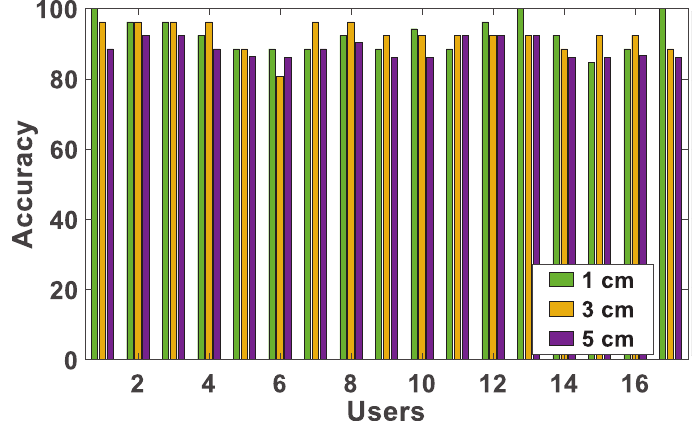
Figure 13. Accuracy at different